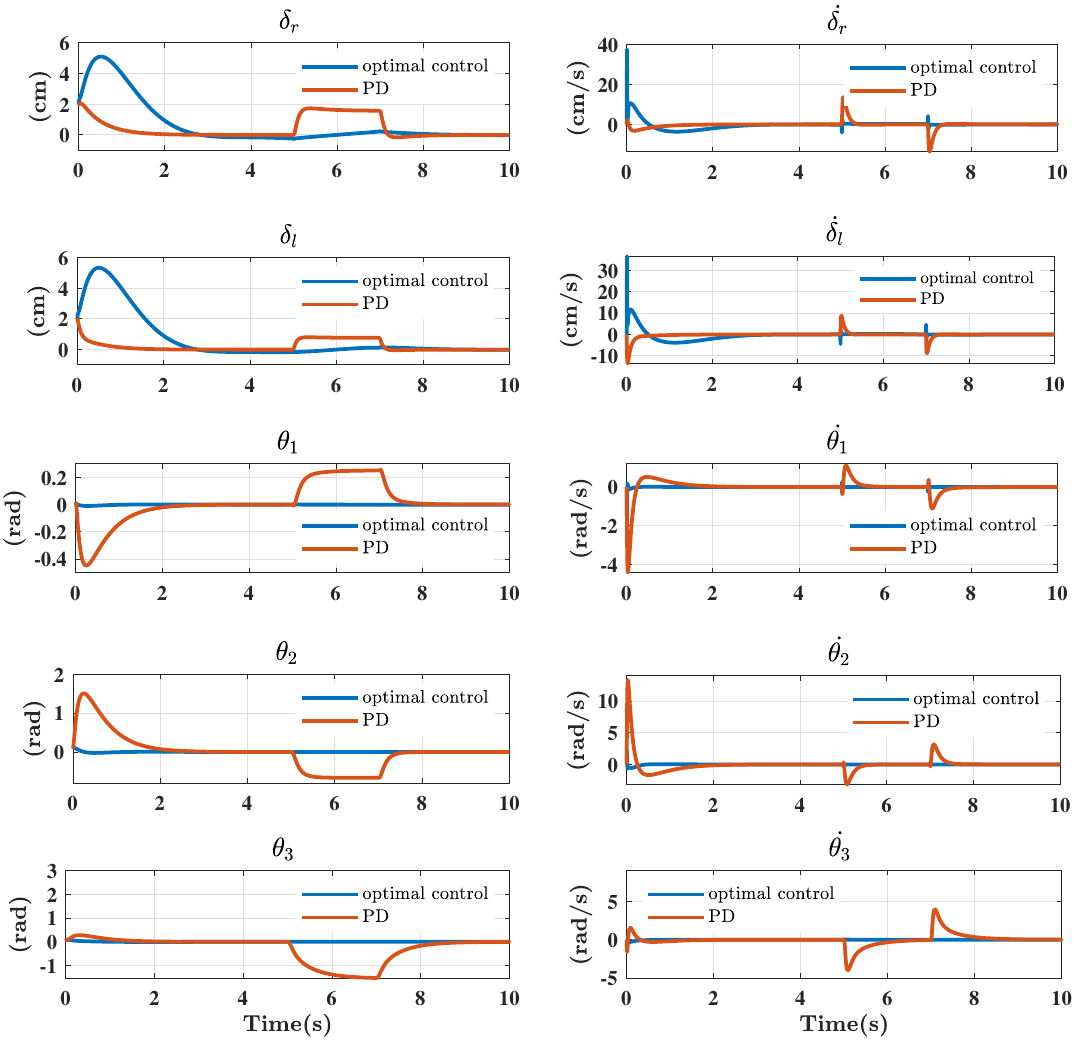
Figure A1. Optimal controller based on disturbance detector vs. PD (Proportional-Derivative)